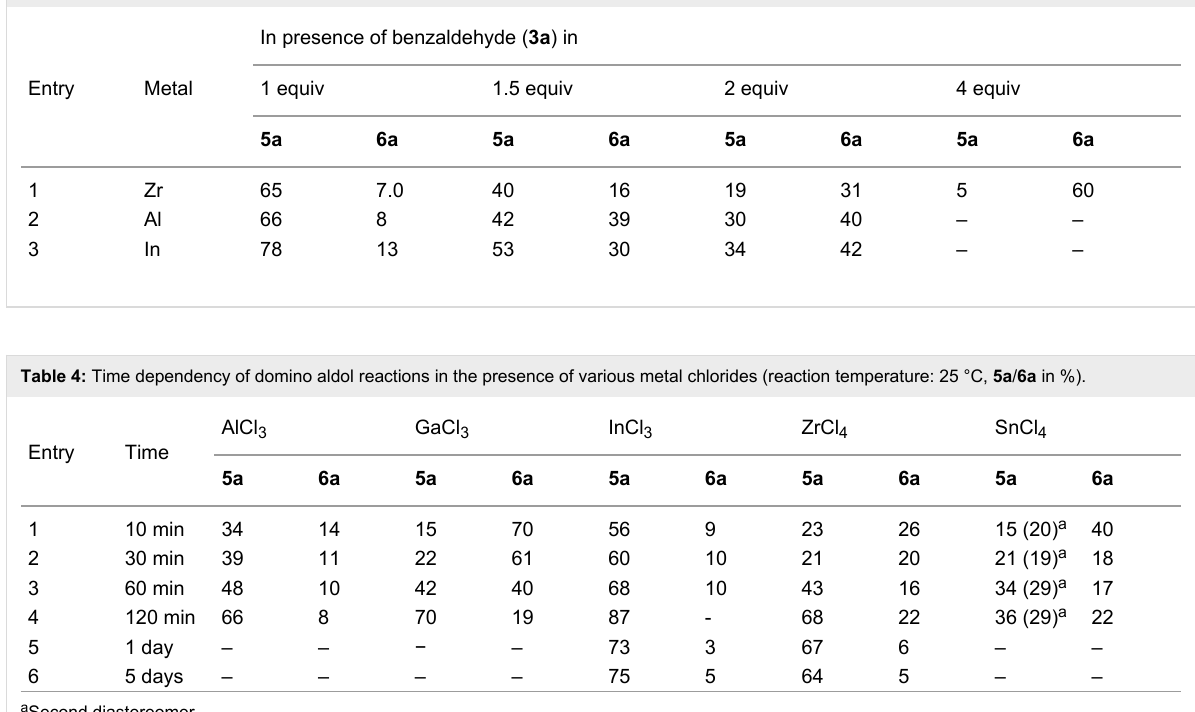
Table 3: Stoichiometry dependence on the amount of aldehyde (reaction time: 2 h, reaction temperature: 25 °C, 5a / 6a in %).